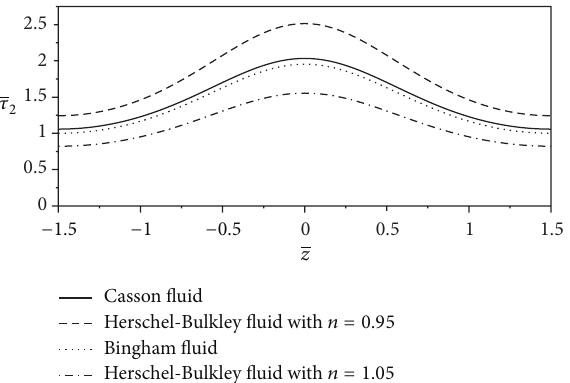
Figure 15: Variations of skin friction 𝜏 2 of Casson fluid model with axial distance for different